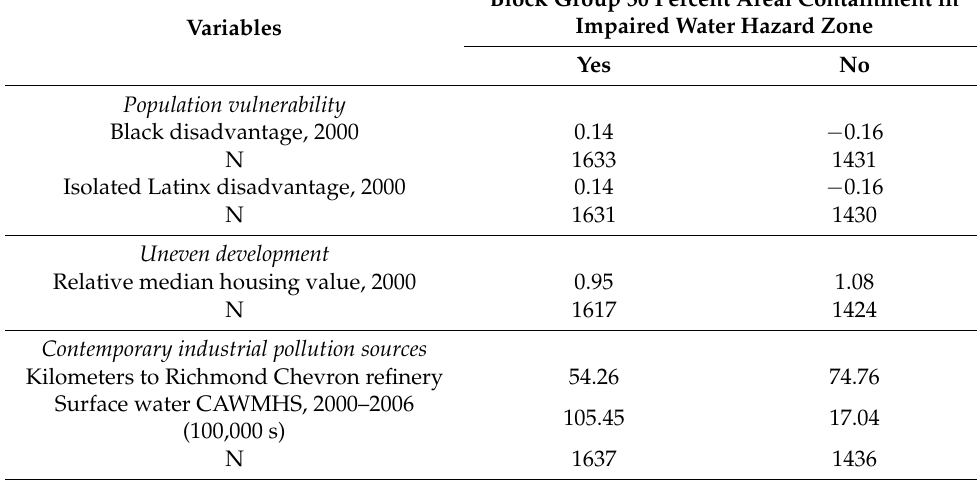
Table 5. Comparison of block group means by 50 percent areal containment within a 2006, 303(d), impaired water hazard